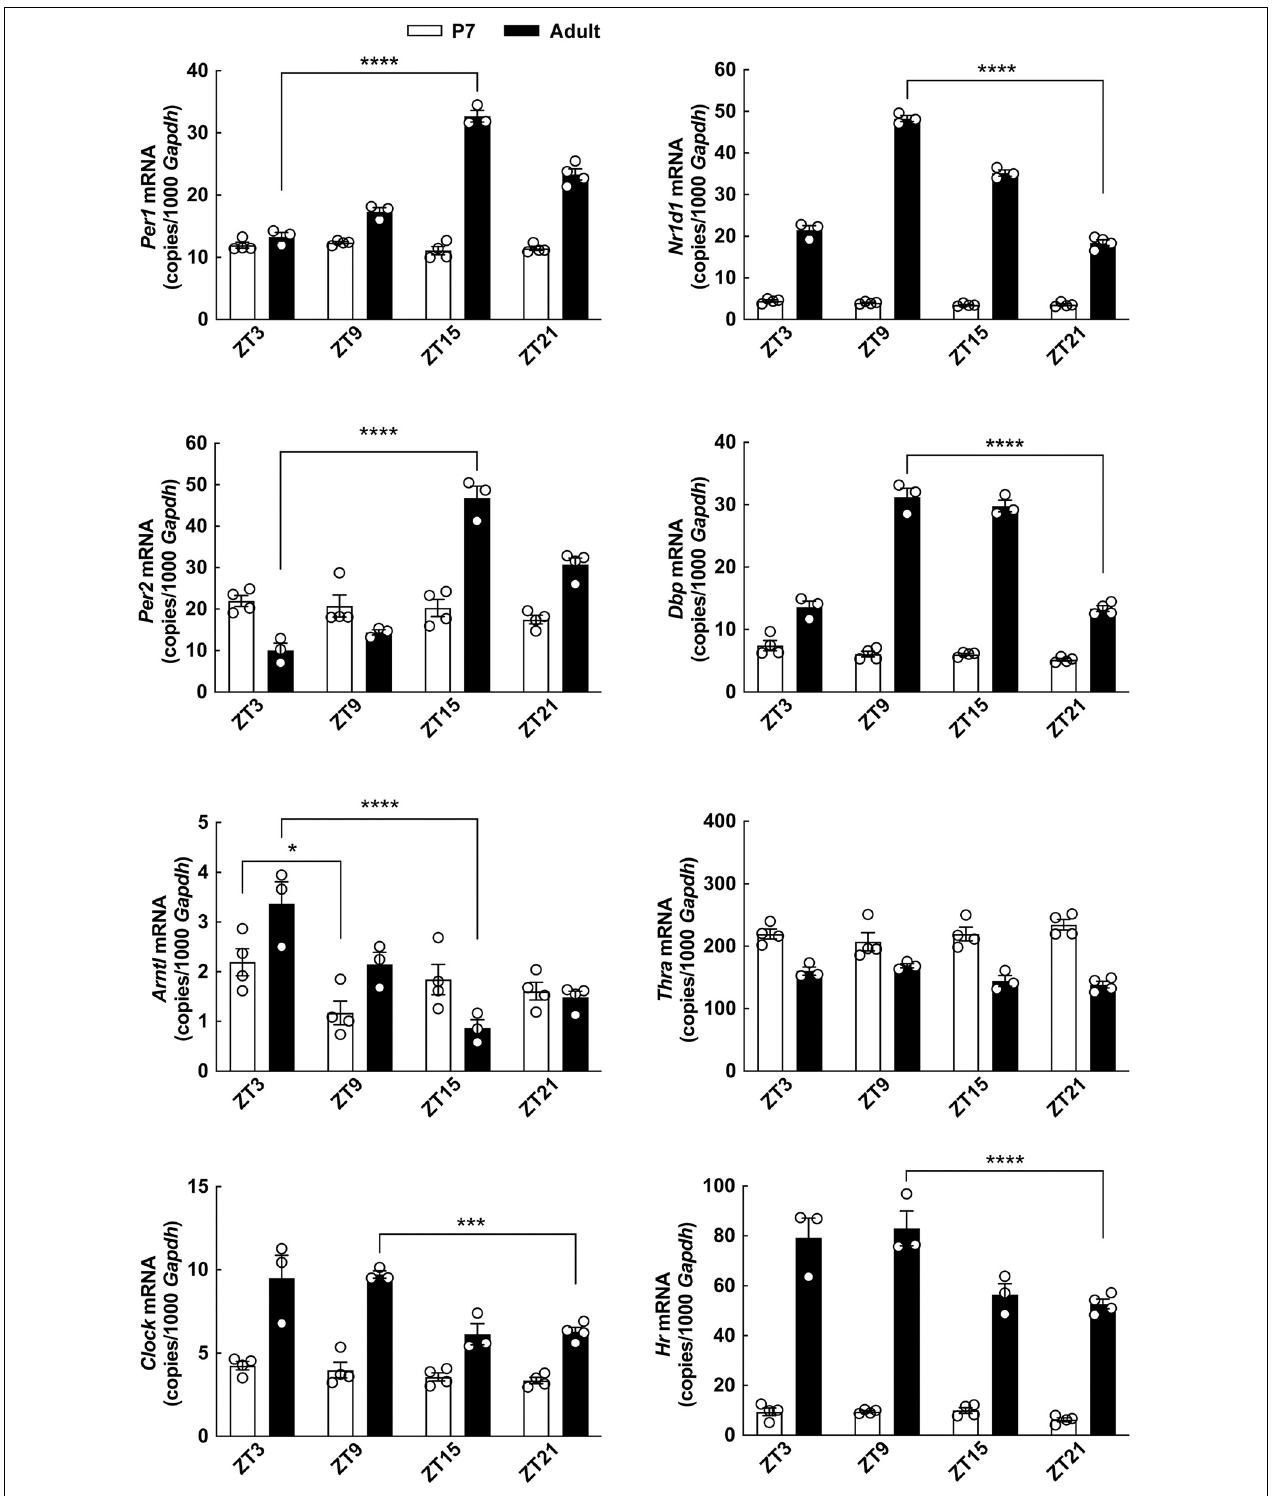
FIGURE 8 | Diurnal profile of clock gene expression in the cerebellum of neonatal and adult rats determined by qRT-PCR. Rat pups (postnatal day 7) and adult rats (8 weeks of age) were kept under a 12 h light/12 h dark schedule and killed in 6-h intervals. Quantitative data were analyzed by two-way ANOVA followed by Bonferroni multiple-comparisons tests. Only significance levels of Bonferroni multiple-comparisons tests comparing the highest to the lowest expression level of each gene are displayed. * p < 0.05; *** p < 0.001; **** p < 0.0001. n = 3–4.